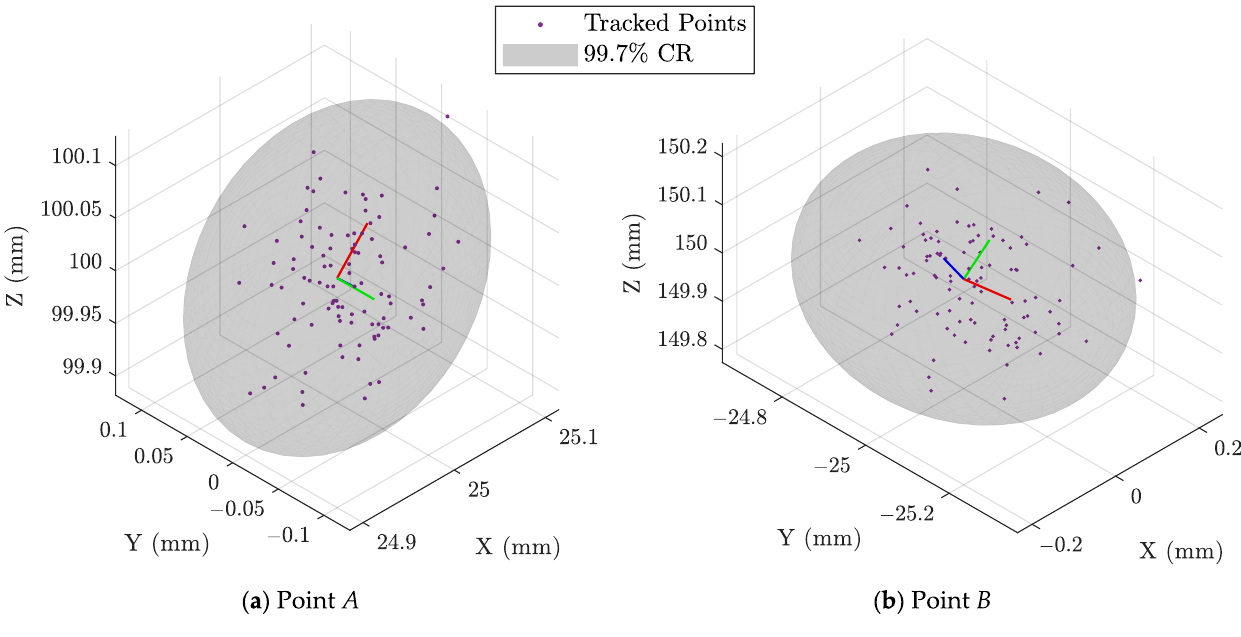
Figure 7. Simulated position error where the signal was perturbed with white Gaussian noise at a level of − 63dB. Tracked positions are visualised in ( a , b ) for end-points A and B of the 128mm flexible sensor depicted in Figure 4. Even though the position noise of A is highly correlated to B , and it is modelled by a 6 × 6 covariance matrix, the two corresponding uncorrelated trivariate Gaussian distributions are visualised through the 99.7% Confidence Regions (CR), which are ellipsoids with the main axes indicated by the RGB